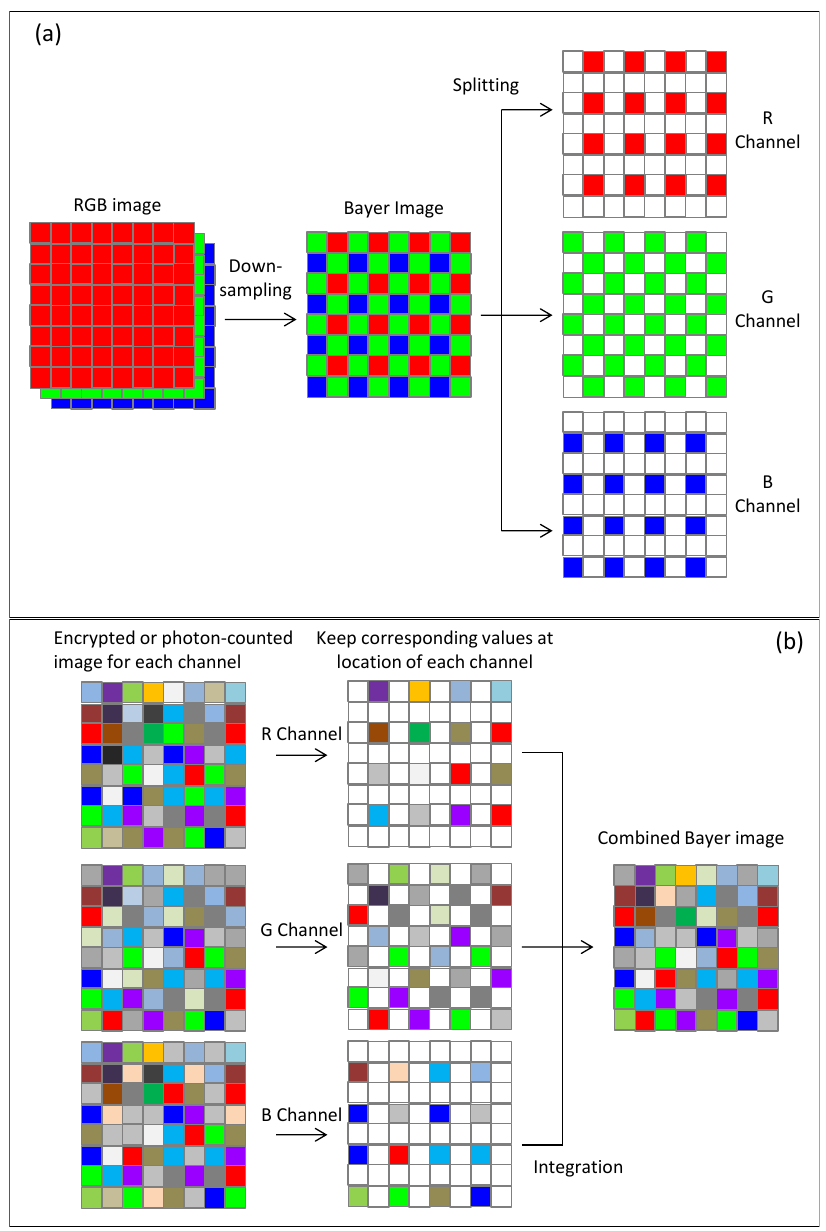
Figure 4. Illustration of down-sampling, image splitting and integration. ( a ) Illustration of down-sampling (from RGB image to Bayer image) and image splitting (from Bayer image to R, G, B channel); ( b ) Illustration of image integration (from R, G, B channel to Bayer image). The pixel in white denotes zero